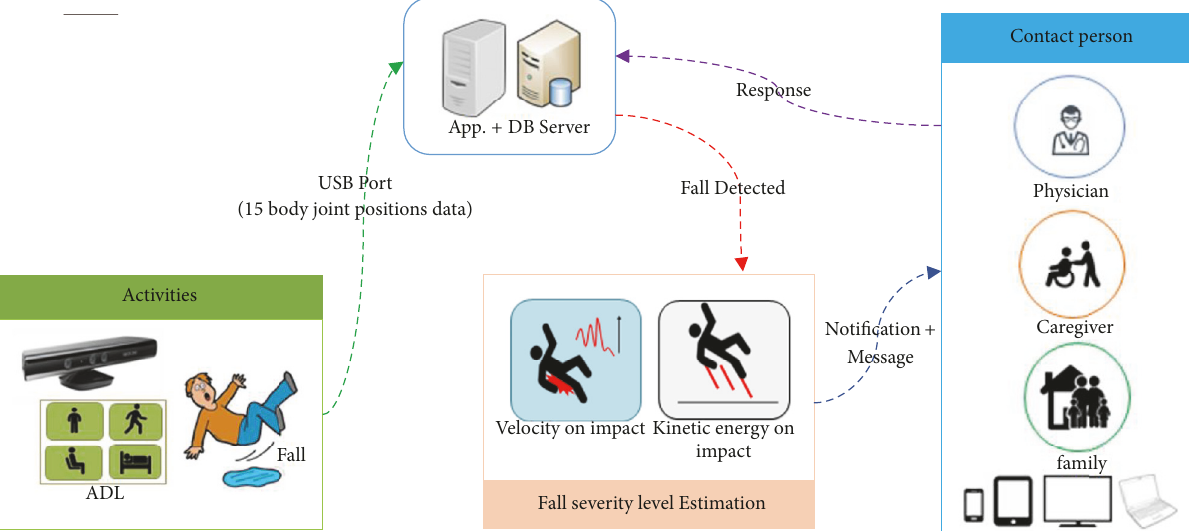
Figure 1: Architecture of proposed system.